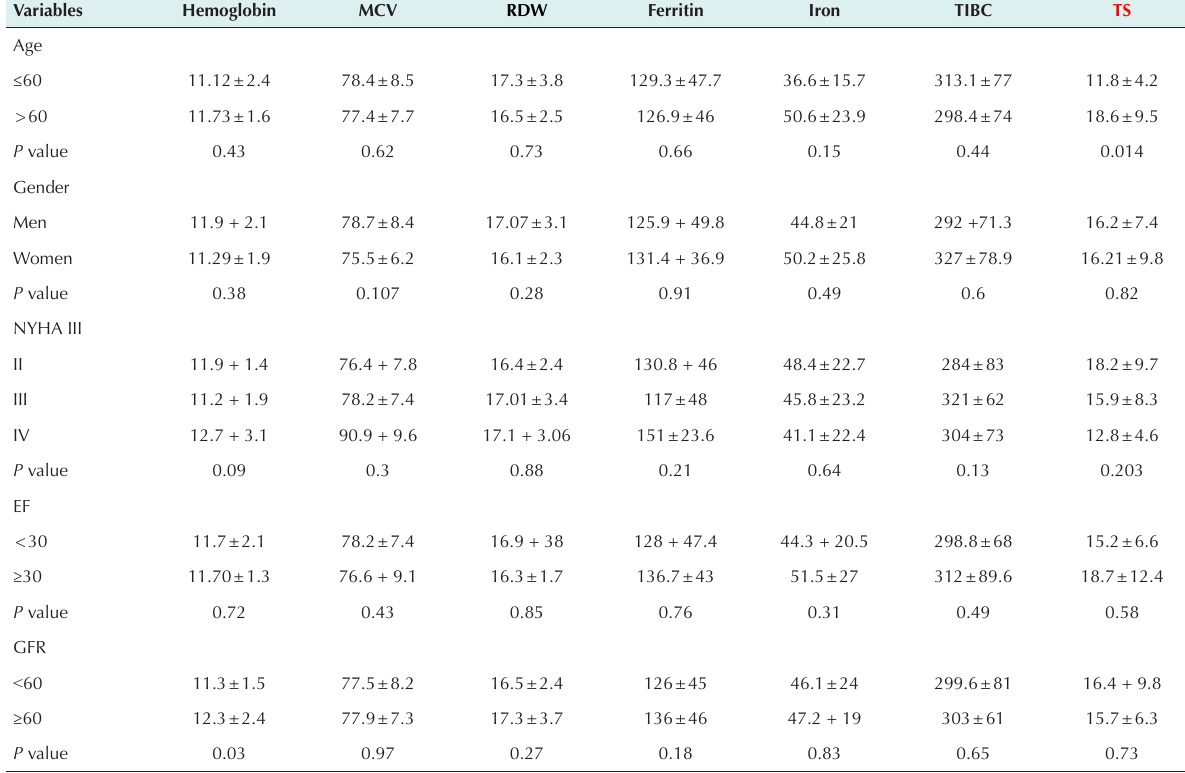
Table 1 . The Association of Study Variables With Age, Gender, NYHA Class, EF, GFR in Anemic Patients Variables